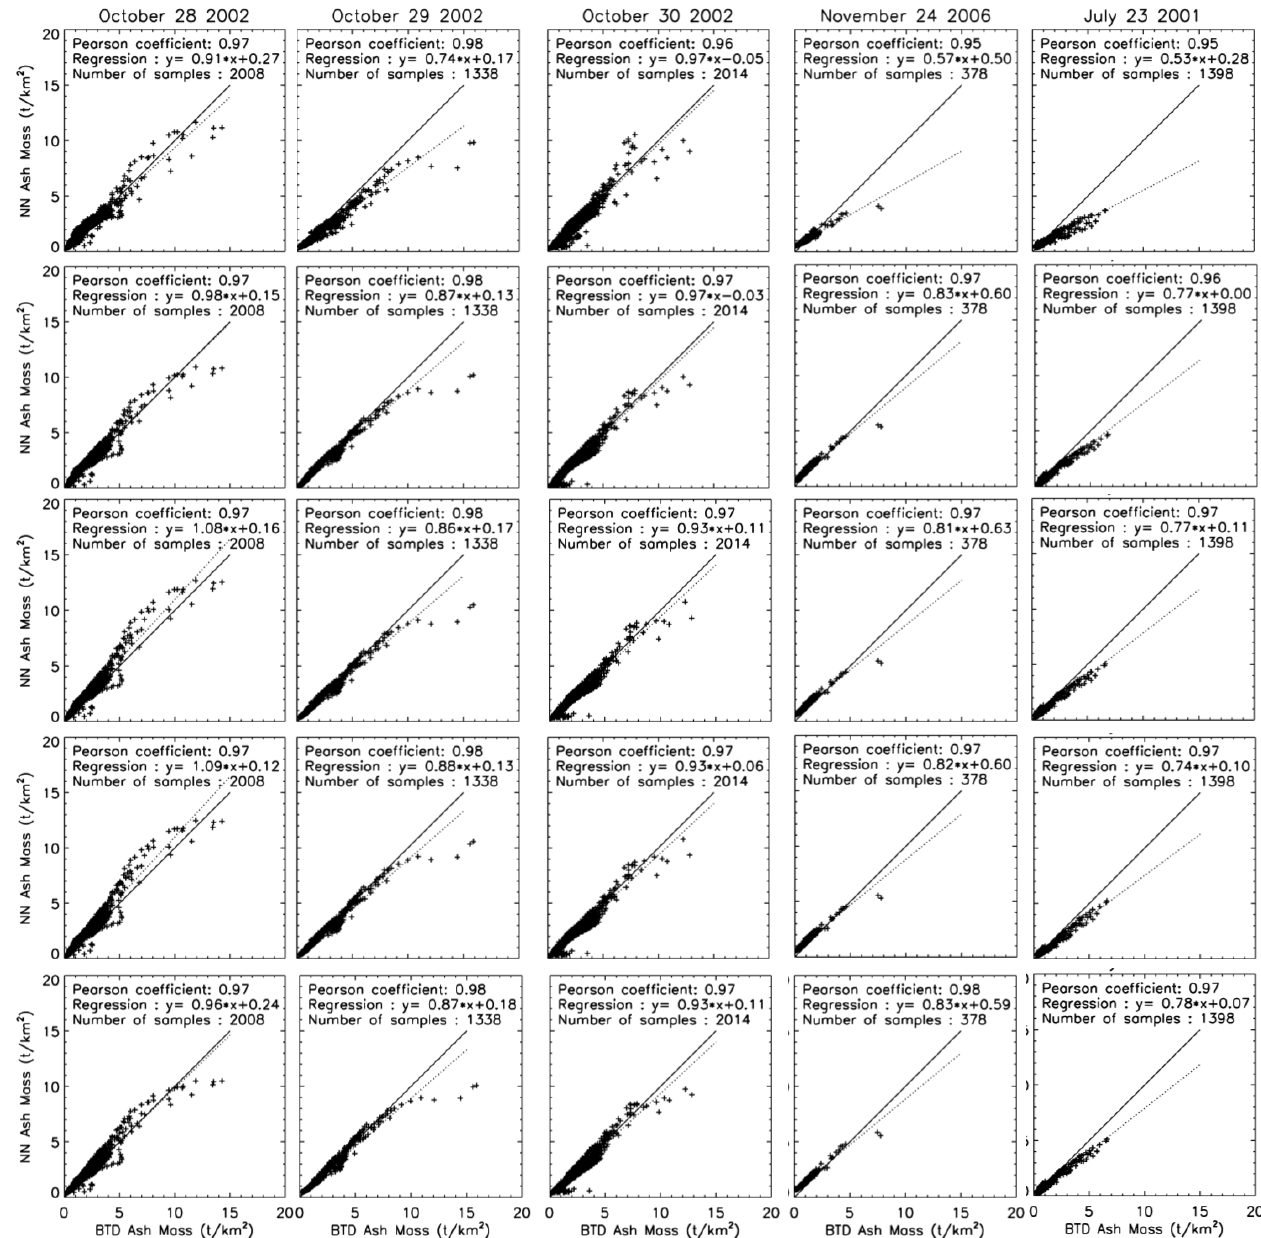
Fig. 6. Scatter plots for the five V sets, from left to right: 28 October 2002, 29 October 2002, 30 October 2002, 24 November 2006, 23 July 2001. From top to bottom results from: NN1 (28 October 2002). NN2 (28 October 2002 + 29 October 2002). NN3 (28 October 2002 + 29 October 2002 + 30 October 2002). NN4 (28 October 2002 + 29 October 2002 + 30 October 2002 + 24 November 2006). NN5 (28 October 2002 + 29 October 2002 + 30 October 2002 + 24 November 2006 + 23 July